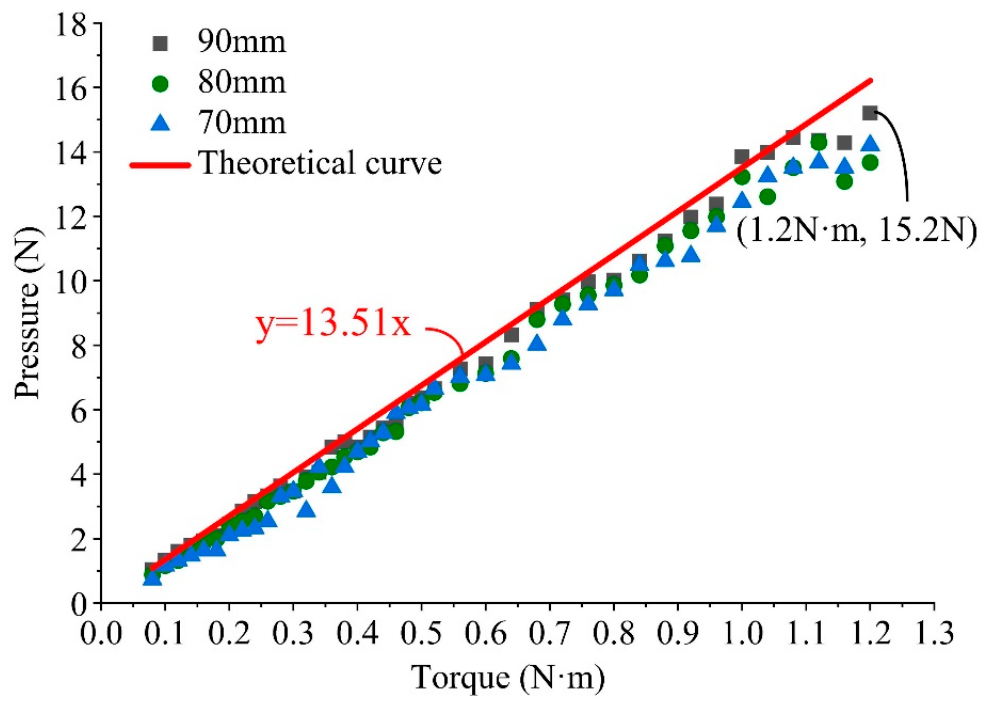
Figure 22. Relationship between torque and gripping force. During the grasping and harvesting tests, the soft gripper was fixed on Franka, a seven-axis robotic arm with a high-sensitivity force-control performance, as shown in Figure 23. The tests were carried out in an orchard located in Changping Distrct,